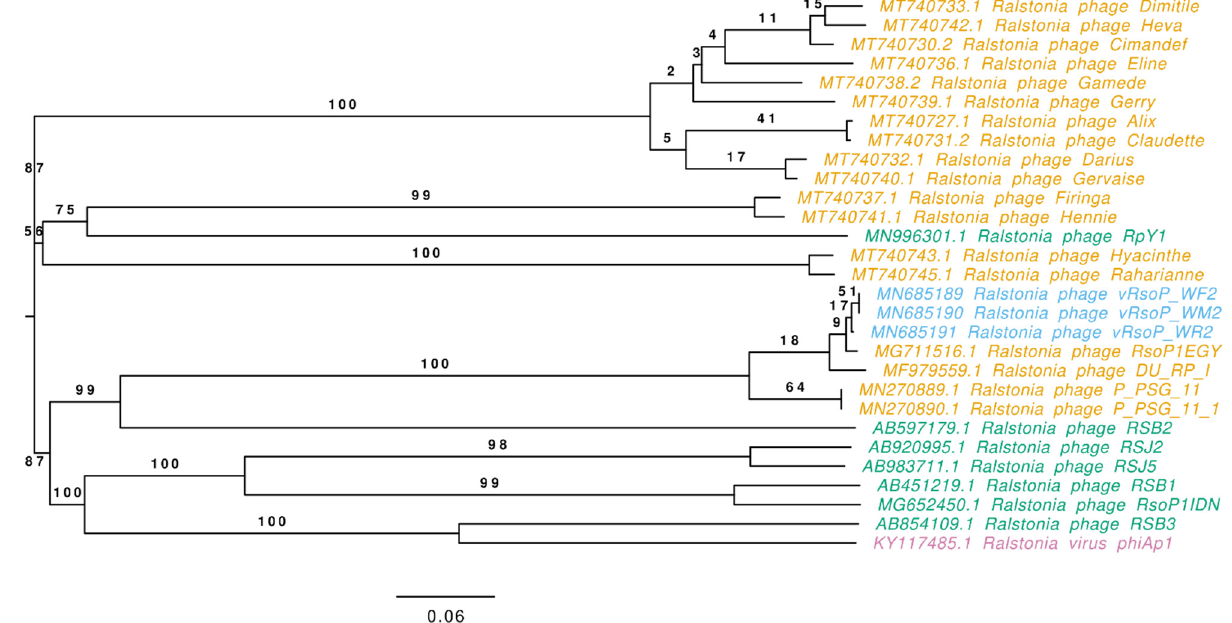
Figure 6. Phylogenetic tree based on genomic distances of European water phages vRsoP-WF2, vRsoP-WM2 and vRsoP- WR2 with a selection of closely related R. solanacearum and R. pseudosolanacearum phages from other sources and continents using VICTOR to calculate intergenomic distances. The geographical origin of the phages is indicated by the following colours: Africa (orange), Asia (green), Europe (blue) and America (purple).